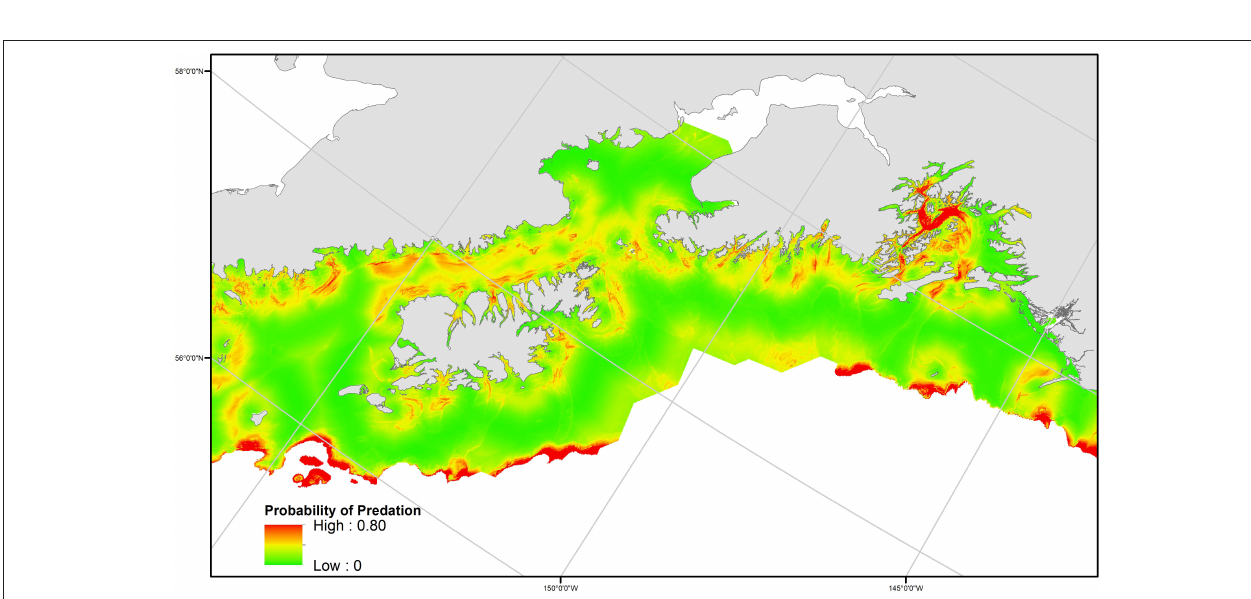
FIGURE 5 | Partial plots for generalized additive models for predation presence/absence variables. Probability of Predation is on the y-axis and environmental variable is on the x-axis. Standard error is shaded in gray.